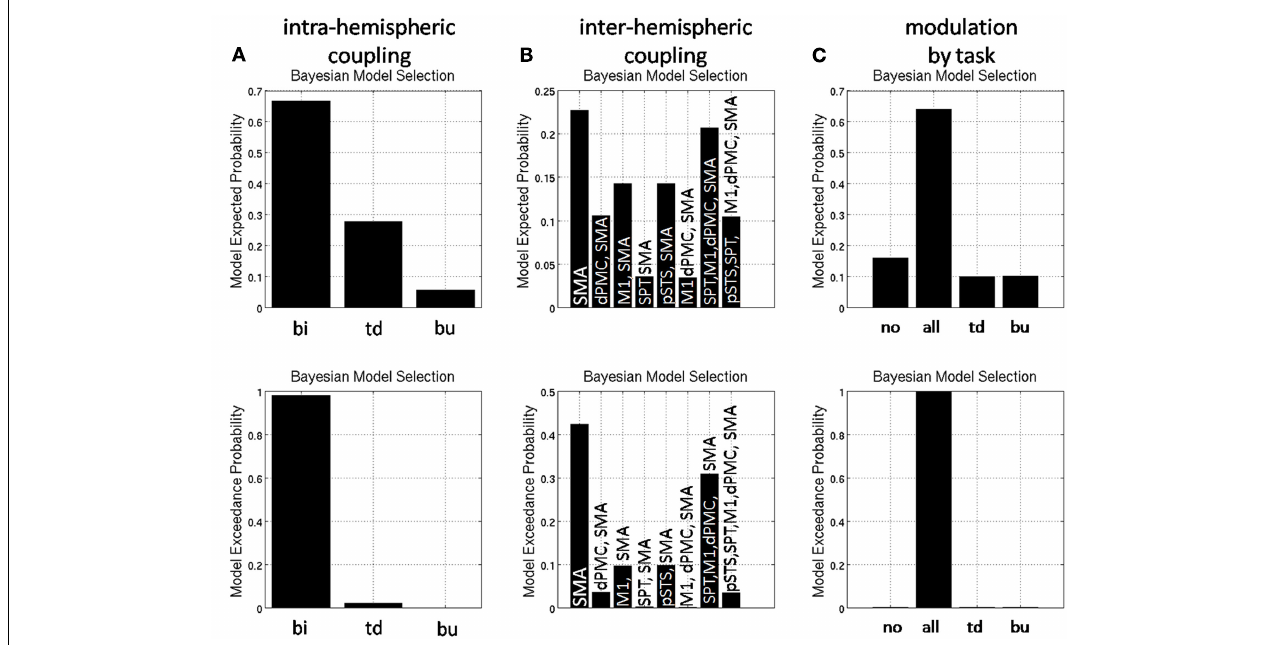
(for abbreviations please see text) and (C) models with different modulatory task effects [no modulation by task (no), modulation of top-down and bottom-up coupling